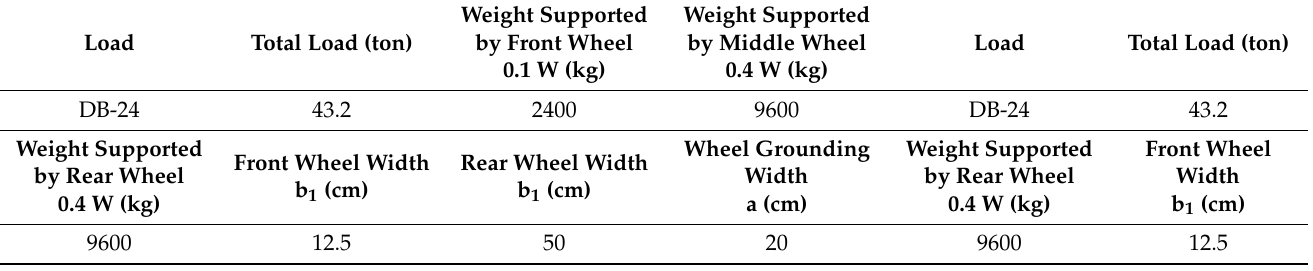
Table 6. Vehicle load input data.